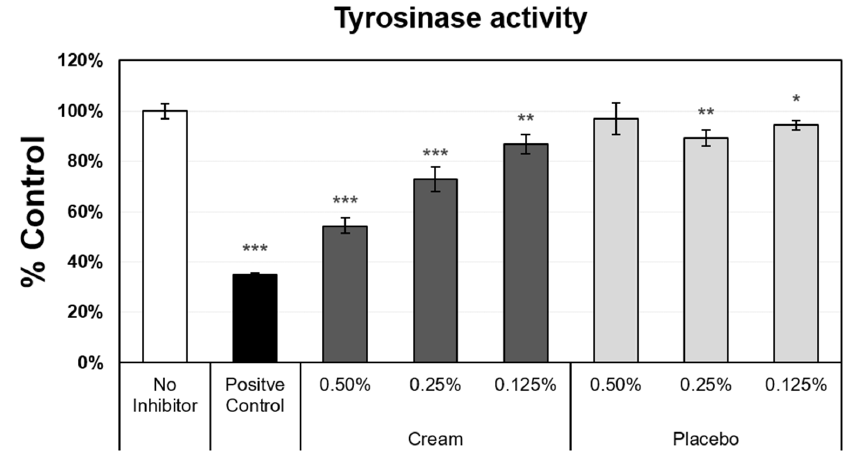
Figure 4. Tyrosinase activity assay using darkly pigmented normal human melanocytes. Mean data ± SD are presented as % control ( n = 4). The negative control did not receive inhibitors (set value, 100%). Glycolic acid was used as the positive control. The placebo (negative control formulation) and cream (test product) formulations were diluted for evaluation. Statistical comparison of the mean values using a t -test (* p < 0.05, ** p < 0.01, and *** p < 0.001).